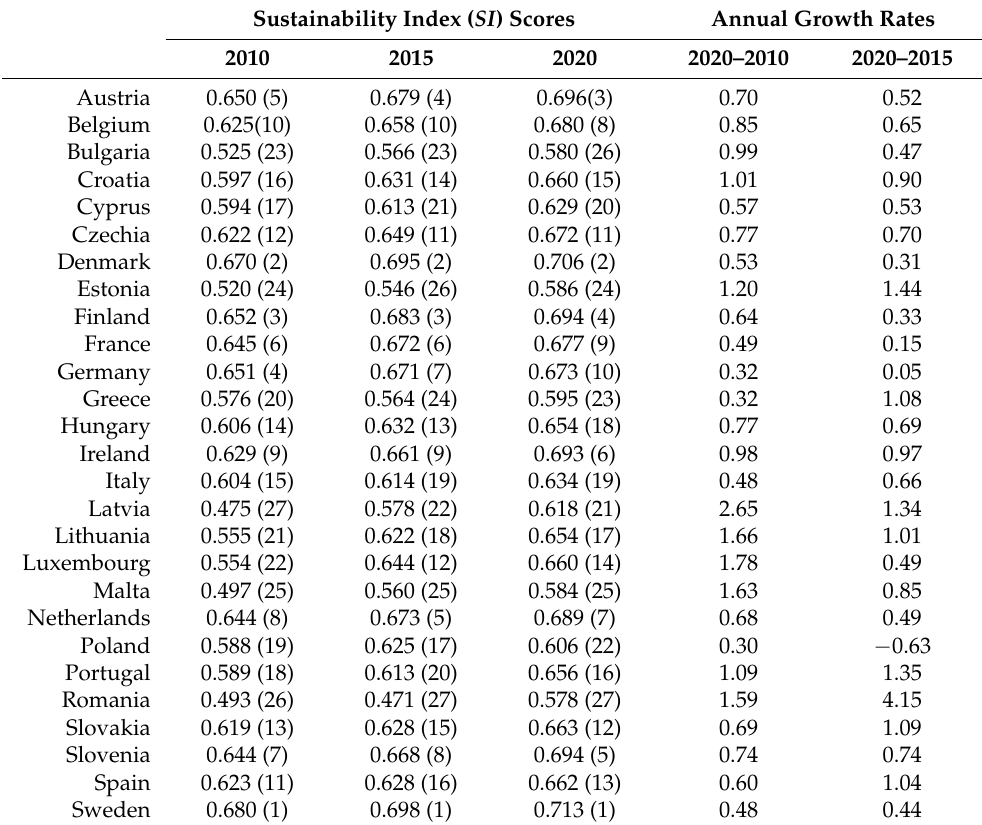
Table 2. Sustainability Index ( SI ) scores (rank order in parenthesis) and annual growth rates.